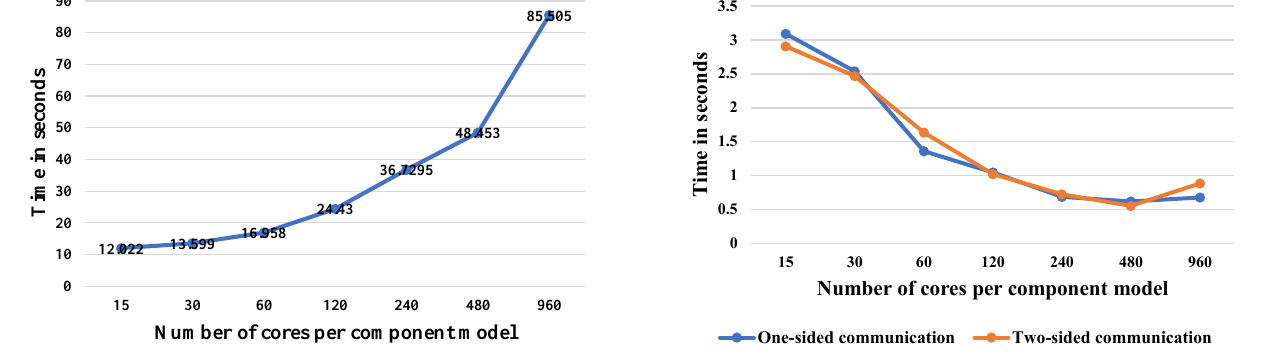
Figure 9. Comparison of data transfer times (for 100 ping-pong couplings) between a one-sided and a two-sided implementation, with the same configuration as Fig.